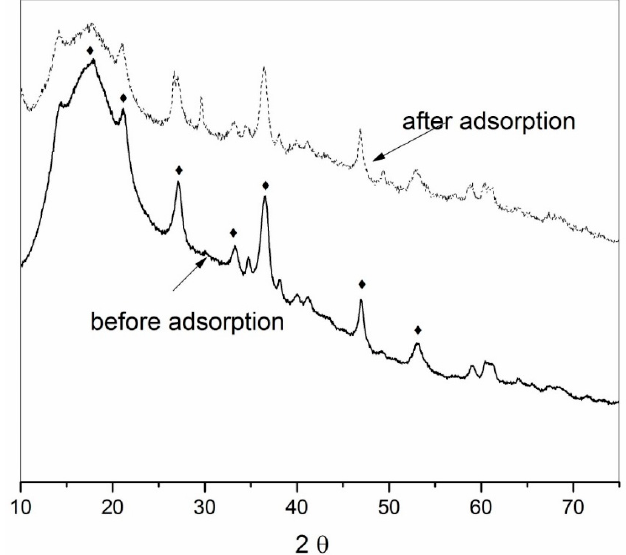
Figure 2. X-ray diffraction (XRD) records of the ER/DETA/FO/FD adsorbent before and after adsorption (experimental conditions for preparation of Se loaded sample: Se initial concentration 5 mg L − 1 , ambient temperature, solid/liquid ratio 0.16 g L − 1 , contact time 300 min). Symbol ( ) denotes characteristic peaks of goethite.